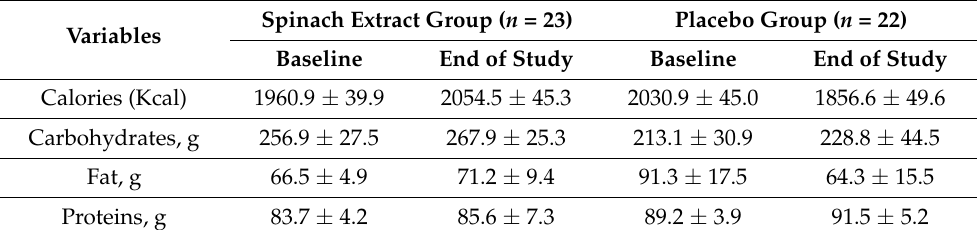
Table 7. Results of nutritional